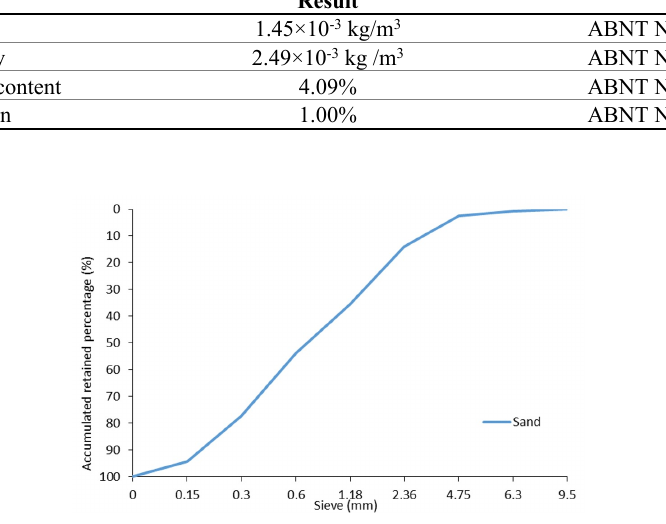
Figure 1. Sand’s granulometric curve